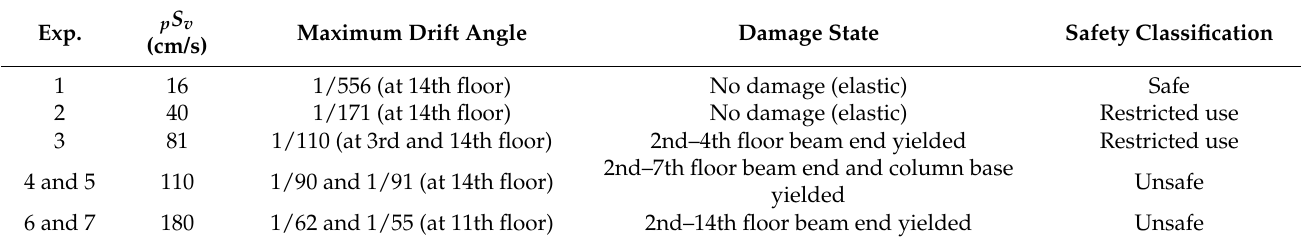
Table 3. Results of shaking table test and its safety